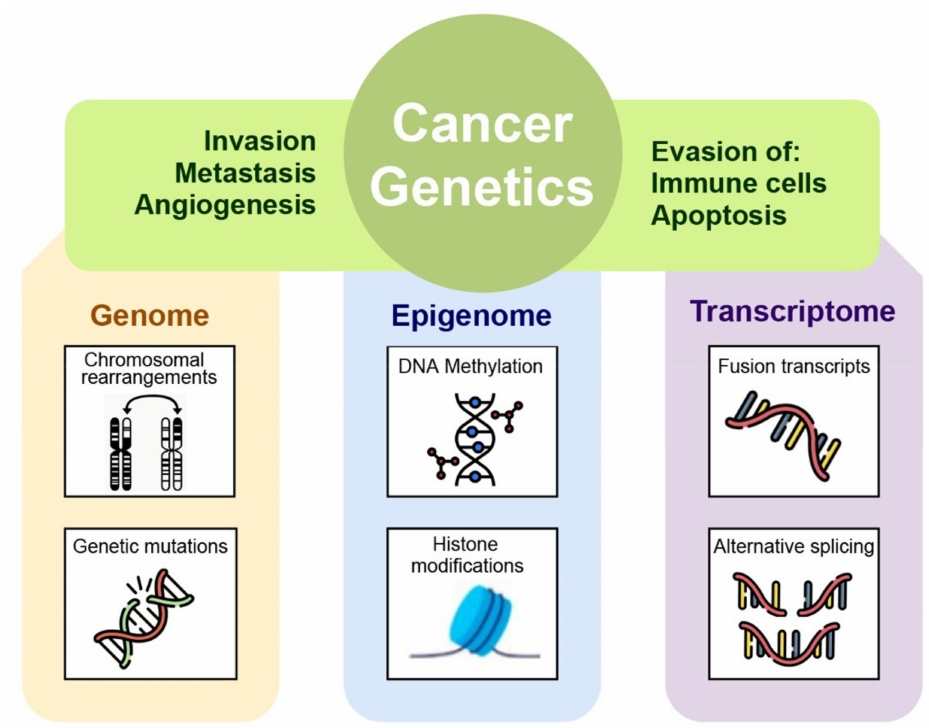
Figure 1. The many levels of interactions found in a cancer system, that can be measured via the different omics technologies, such as genomics, epigenomics, transcriptomic, and